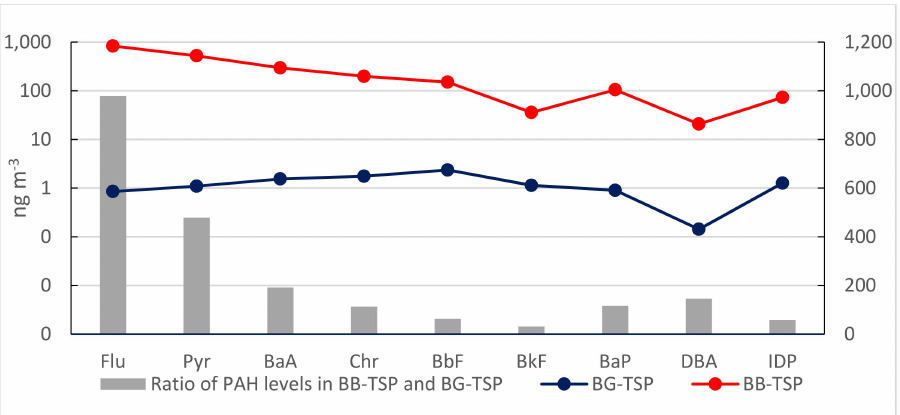
Figure 3. Comparison of PAH levels 1 in TSP between BG 2 and BB 3 samples. 1 The values in Figures 2 and 3 were the mean values of individual PAH concentrations (ng m − 3 ) from BG and BB